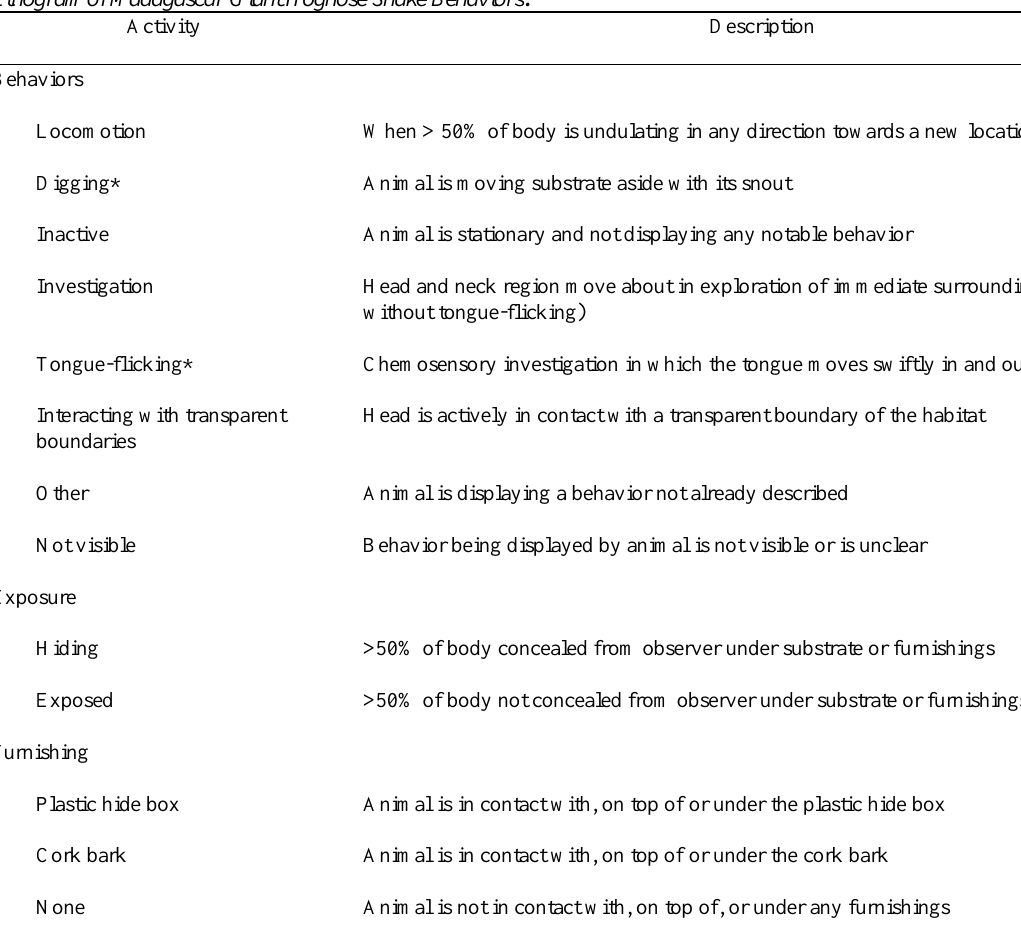
Ethogram of Madagascar Giant Hognose Snake